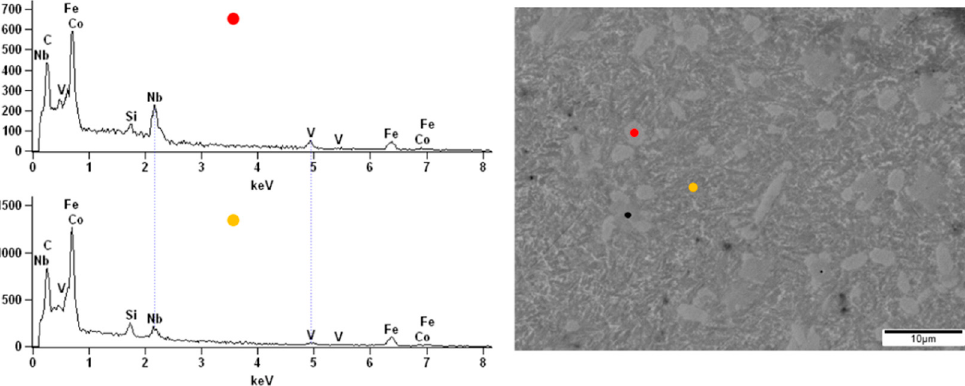
Figure 12. The SEM micrographs of surface and spectrums of the point EDX analysis for the Fe 57 Co 10 B 20 Si 5 Nb 4 V 4 alloy.